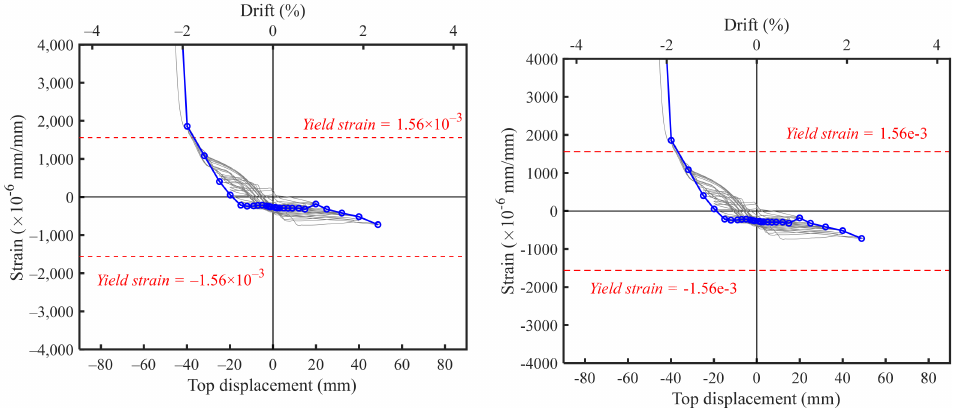
Figure 20. Strain response of vertical bars for upper wall part of W2-R (No. 4 gauge in Figure